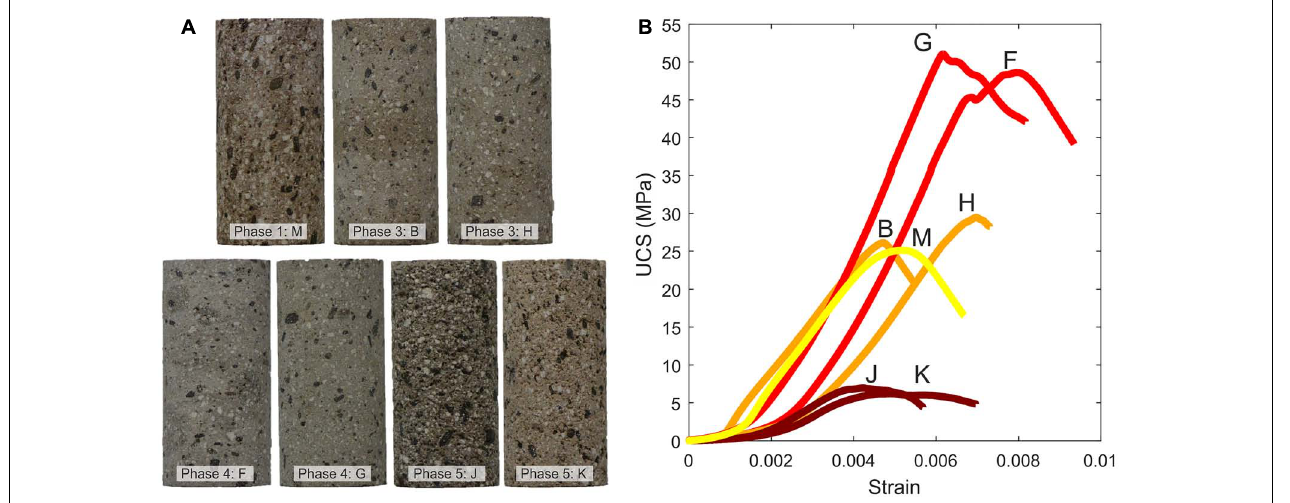
FIGURE 7 | (A) Photos of one core from each block tested (M; B; H; F; G; J; K), with the corresponding phase marked; (B) UCS results from tests carried out at a constant strain rate of 10 - 5 s - 1 on one core from Phase 1, and two cores from Phases 3, 4, and 5. UCS curves labeled with the block from which each rock was cored. Phase 5 samples show creep-like (i.e., undergoing significant strain prior to failure) behavior due to high porosity, while the other samples display sharp failure curves.